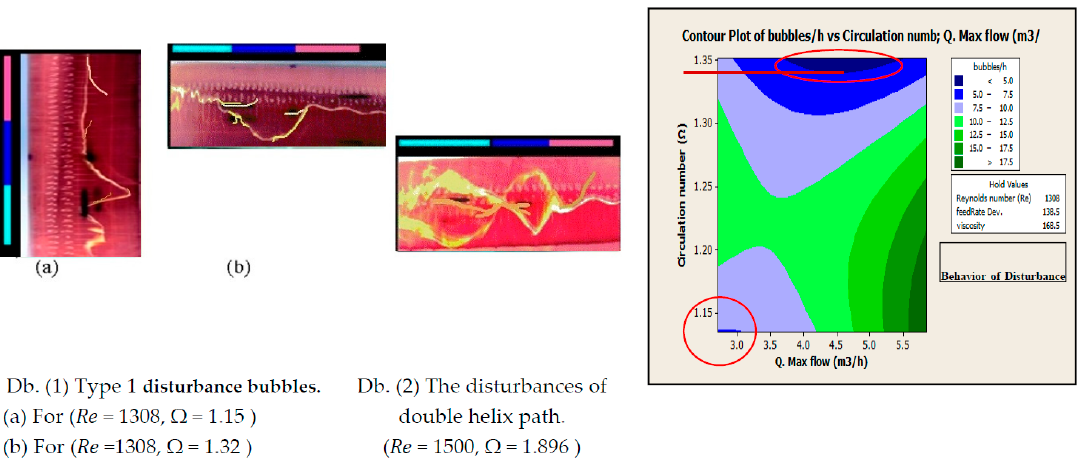
Figure 16. ( a ) Type 1, The Db (1, a) and the Db (2, b) for the Disturbance and double helix waste Figure 16. Type 1, Disturbance and double helix waste.